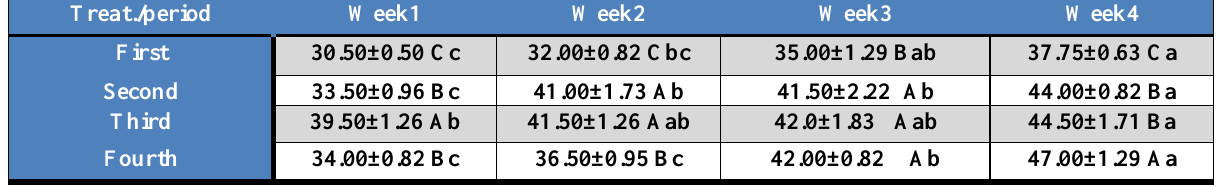
Table, 2: Effect of Vit. C and/or Vit.B on the PCV (%) of rabbits (Mean ± SE).